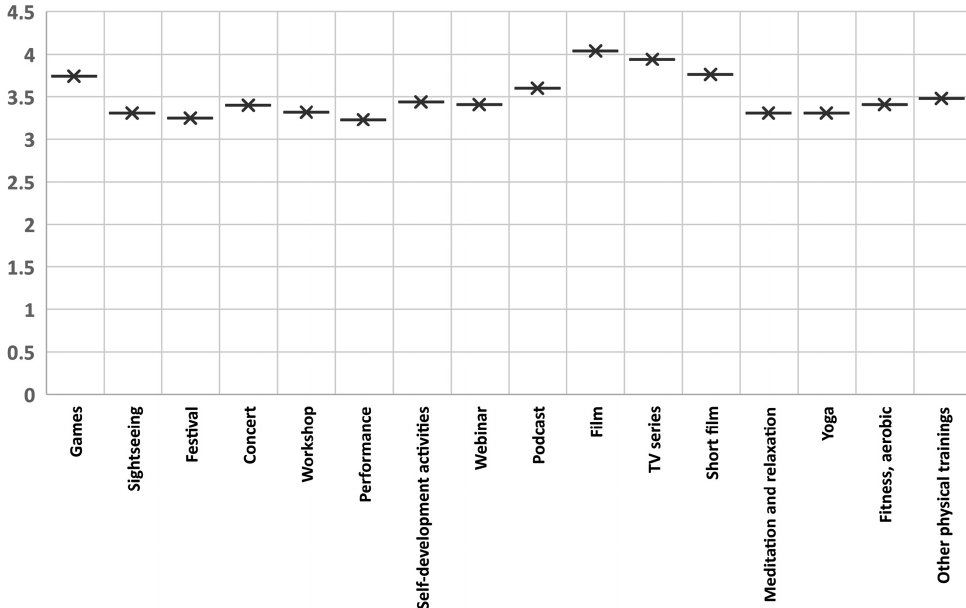
Fig. 3. computer-based entertainment activities undertaken by the respondents, and their rating in terms of the replacement of the real world (scale: 0–5). Source: own elaboration based on online